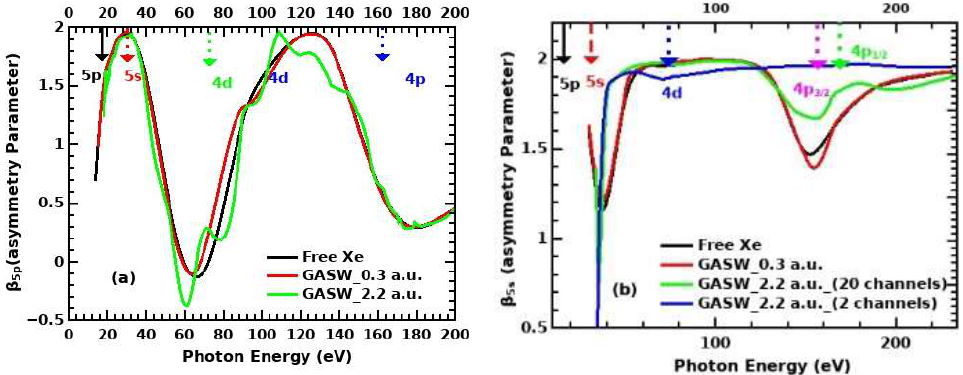
Figure 13. The average angular asymmetric parameter of free and Xe@C 60 for ( a ) 5p and ( b ) 5s orbitals. Vertical arrows indicate the threshold values of the corresponding subshells used in the RRPA.